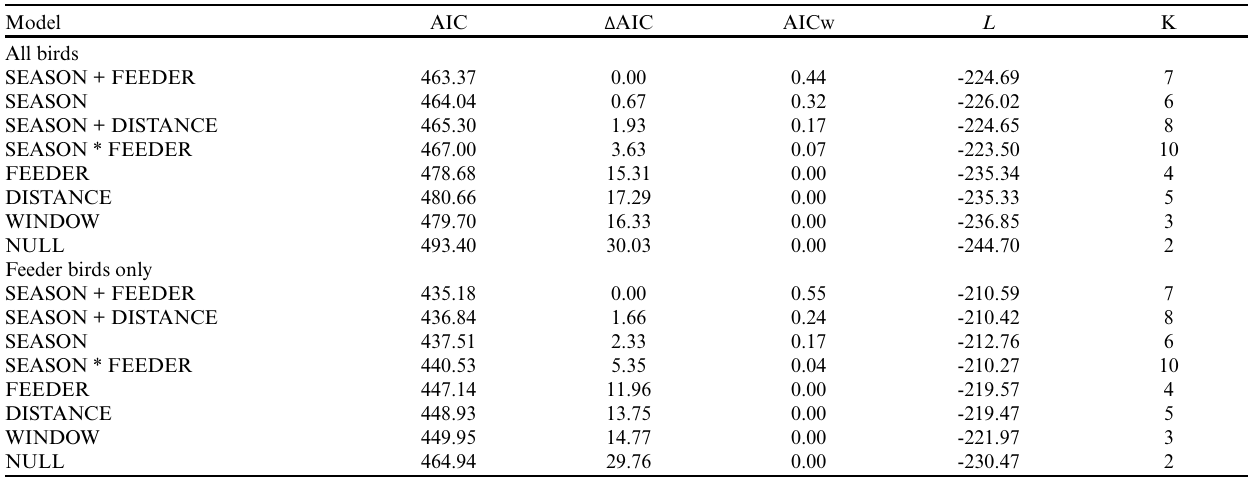
Table 2 . Akaike information criterion (AIC) scores for each model looking at the factors affecting bird-window collisions at residential houses. Summary also includes the relative difference between models and the best model ( Δ AIC), Akaike weights (AICw), log-likelihood (L), and number of parameters (K). All tests were run twice: once with all reported collisions and again after removing collisions from Cedar Waxwings ( Bombycilla cedrorum ), Bohemian Waxwings ( Bombycilla garrulus ), and American Robins ( Turdus migratorius ). Model AIC Δ